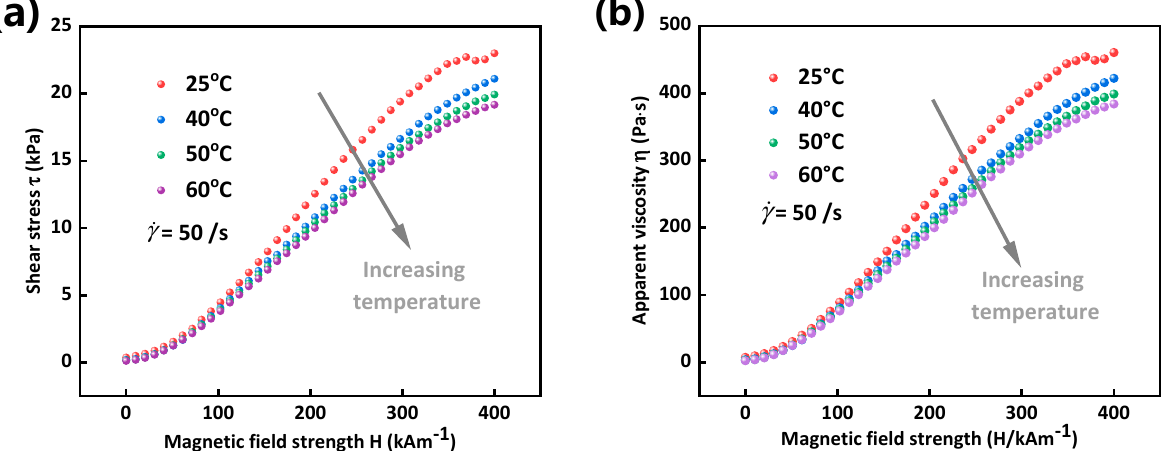
Figure 4. Shear stress ( a ) and apparent viscosity ( b ) as a function of magnetic field strength under different temperatures.